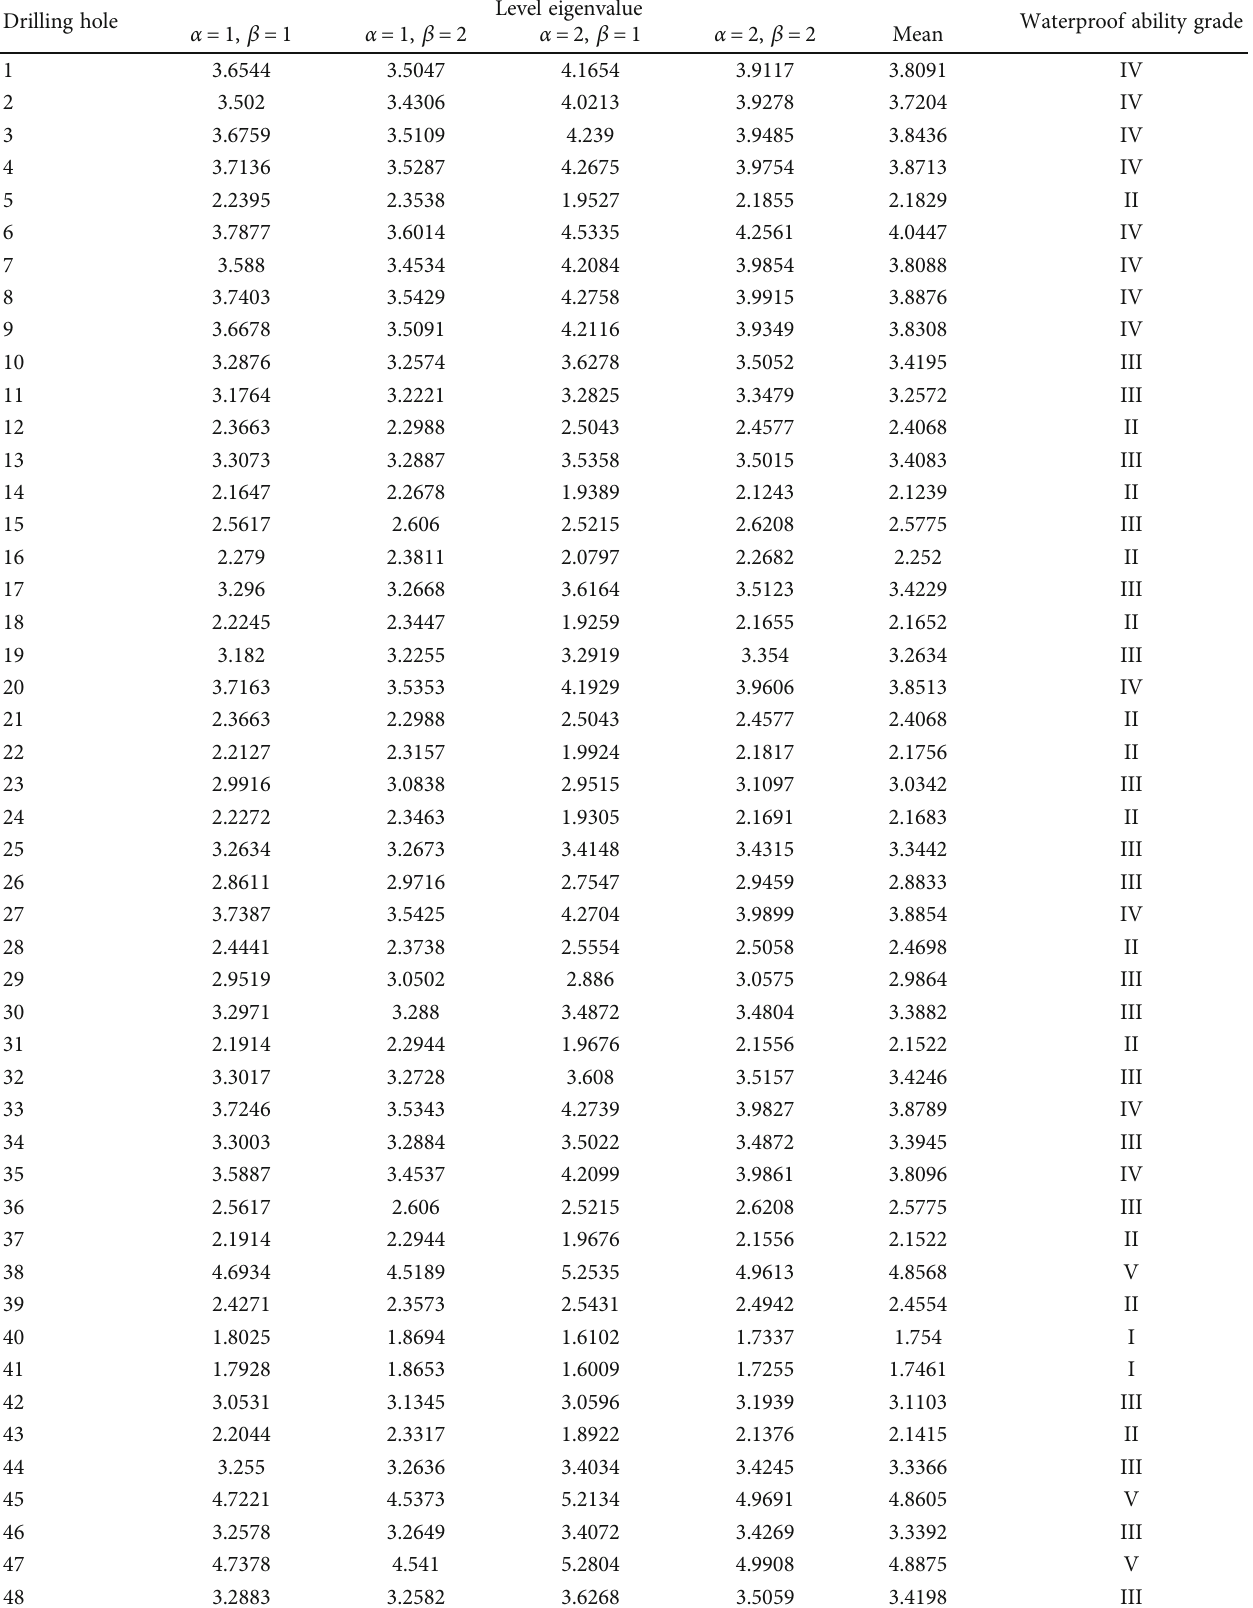
Table 11: Evaluation results of each borehole in the mining